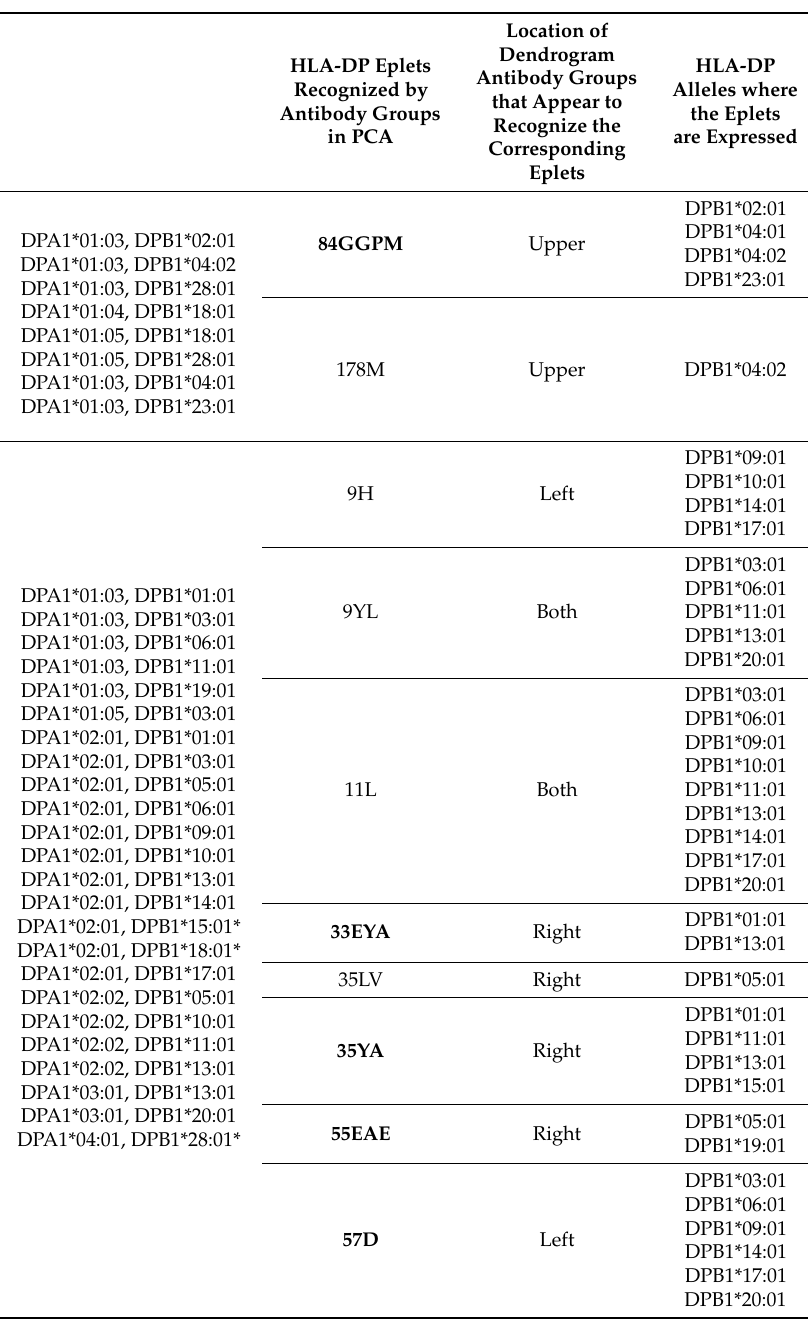
Table 3. Epitopes found exclusively in each of the groups resulted from 1st–2nd plot of PCA and phylogenetic analysis of anti-HLA-DP responses. Eplets within each group are listed in the second column. Eplets in bold are those present in more than one allele in each group and have intermediate or high Ellipro scores. The third column shows the secondary branch of the corresponding dendro- gram in which each distinct response is found. This secondary clustering indicates that some of the epitopes might diverge the anti-HLA response to one direction or both. Eplets with very low or low ElliPro scores are less likely to drive the respective immune